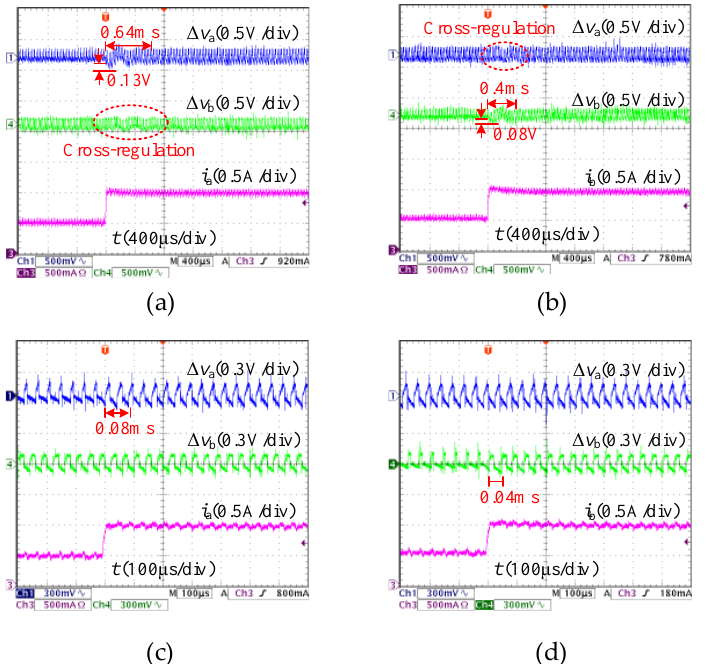
Figure 11. Experimental waveforms of PCCM SIDO buck converter with output load step-up variation: ( a ) change i a under voltage mode control; ( b ) change i b under voltage mode control; ( c ) change i a under voltage ripple control; ( d ) change i b under voltage ripple control.